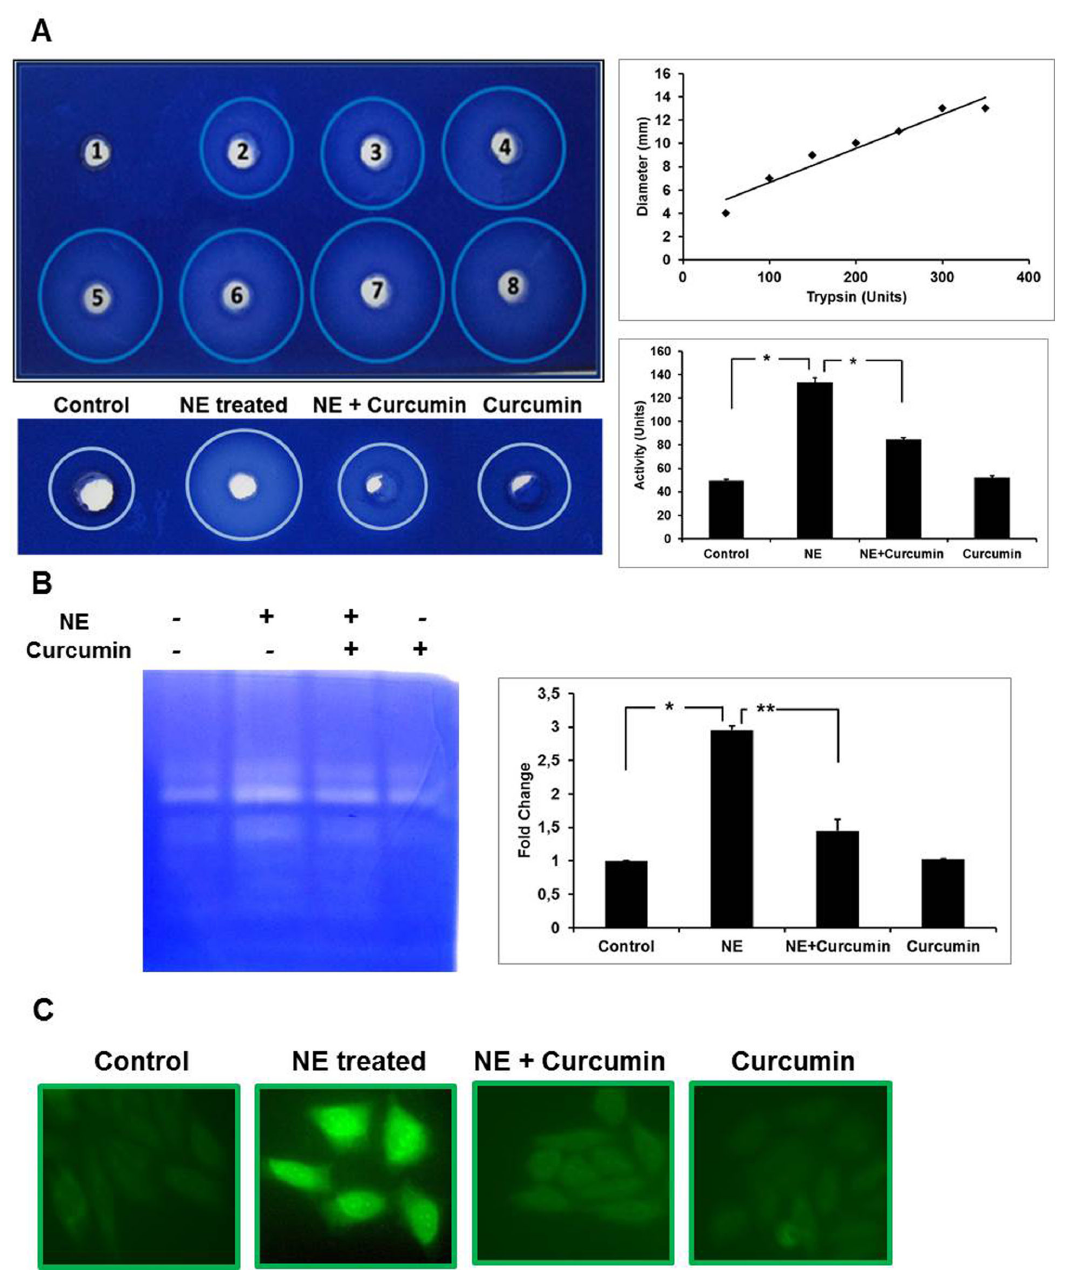
Figure 3. Effect of curumin on gelatinolytic activity. A ) Gel-diffusion assay : Upper gel: Various concentrations of trypsin (1- Blank; 2-5 µg/µl; 3-10 µg/µl; 4-15 µg/µl; 5-20 µg/µl; 6-25 µg/µl; 7-30 µg/µl; 8-35 µg/µl) were added to different wells and protease activity was observed as digested zones around it. A standard curve of the enzyme activity in units as a function of diameter of zone was prepared. The enzyme activity for different samples shown in the lower gel (Control; NE-treated; NE+Curcumin-treated; Curcumin-treated alone) was calculated from the standard graph and represented as a histogram (*P<0.01). The difference of NE- treated was significant to control as well as NE+Curcumin-treated group. B ) Gelatin Zymography : Samples in different lanes of zymograms starting from the left represented as Lane-1: Control; Lane-2: NE-treated; Lane-3: NE+Curcumin-treated; Lane-4: Curcumin-treated alone. The fold change in the activity for bands corresponding to MMP-9 with respect to control was quantified using ImageJ and plotted as histogram (*P<0.01, **P<0.05). C ) in-situ Gelatin Zymography : The experiment was carried out under different experimental conditions above and images captured by fluoresencent microscope at 20X magnifications are represented. doi: 10.1371/journal.pone.0076519.g003 PLOS ONE |